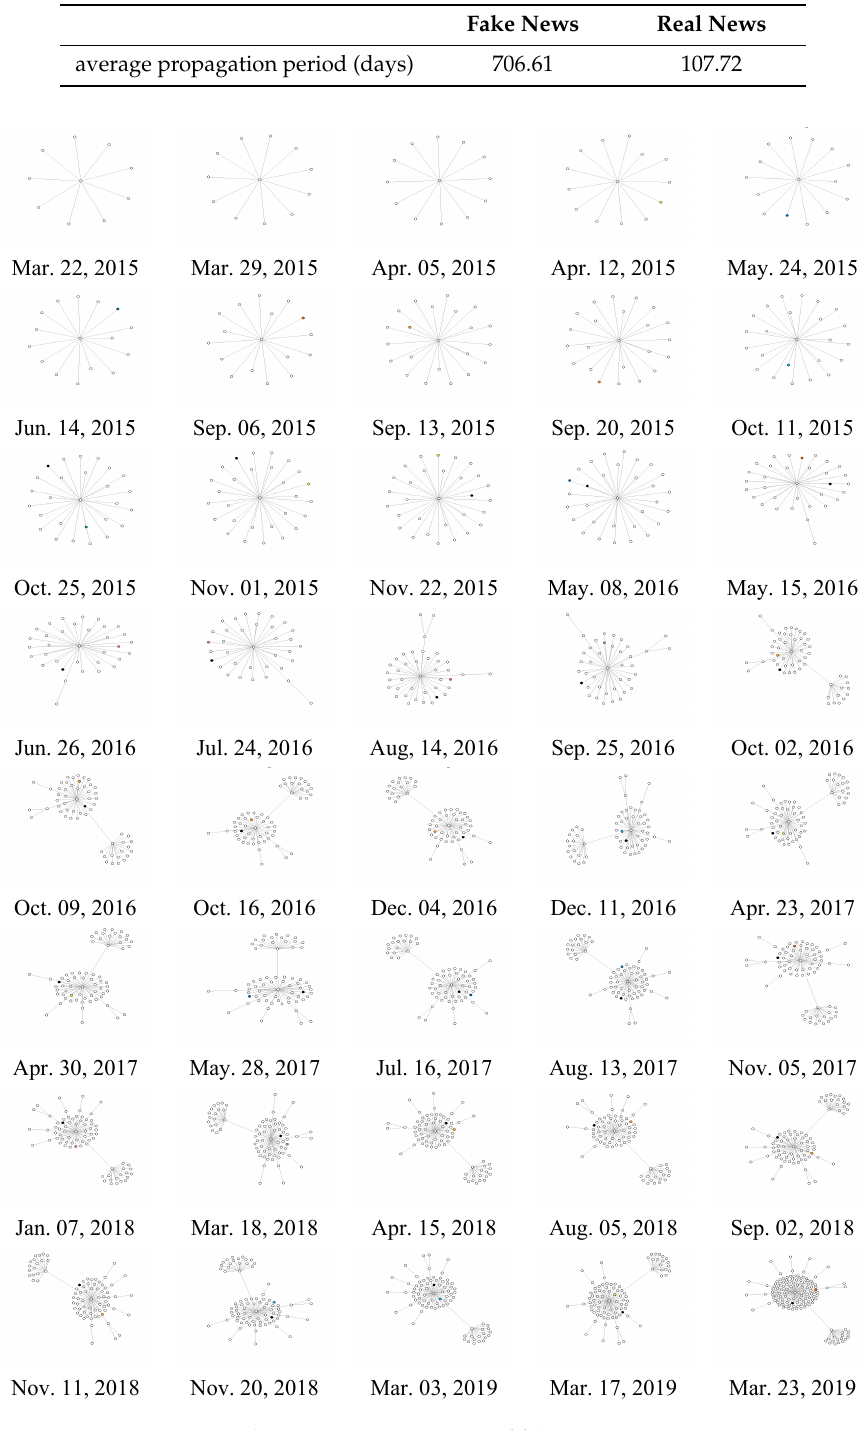
Figure 8. The TW propagation tree of fake news over time.